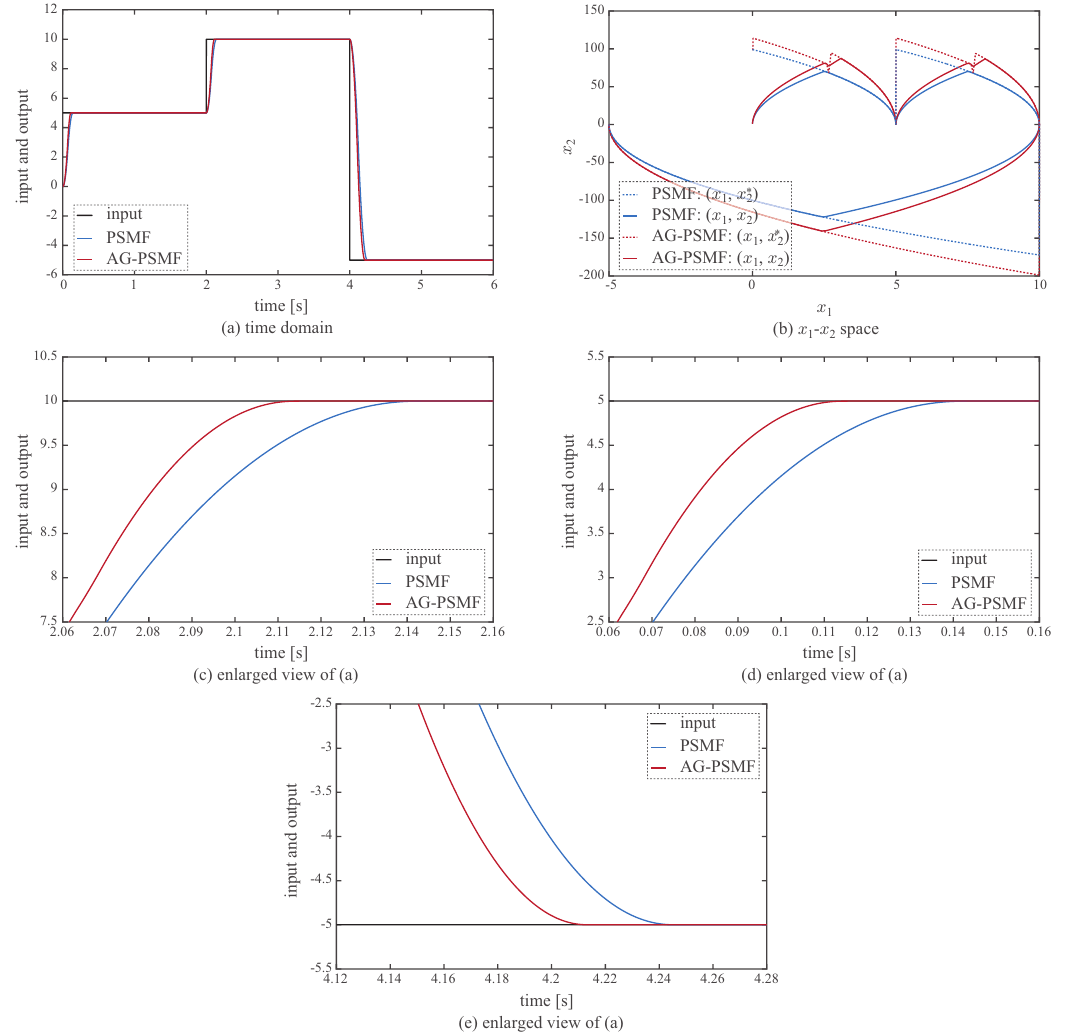
Figure 8. ( a – e ) Behaviors of AG-PSMF and PSMF for an input with step changes. (AG-PSMF: F = 1000, H = 3, N max = 5, N c = 4, R = 0.00075; PSMF: F = 1000, H = 3; T = 0.001